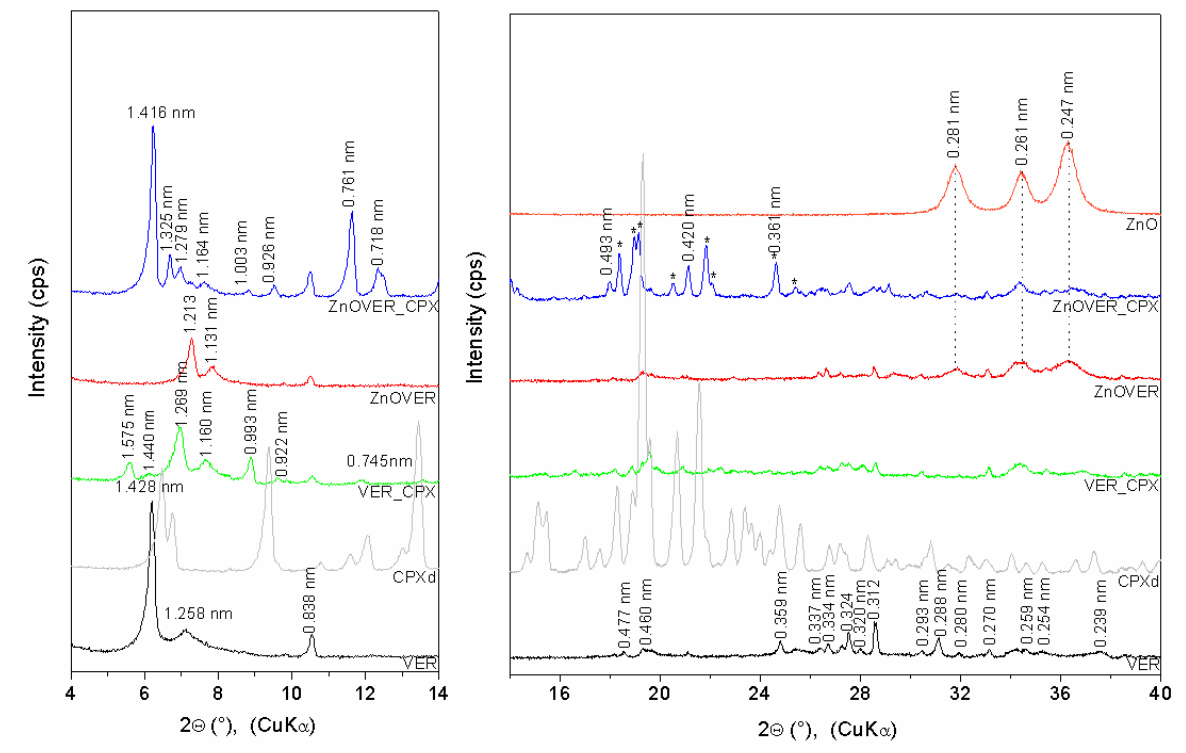
Polymers 2021 , 13 , x FOR PEER REVIEW Figure 1. XRD patterns of initial VER and ZnOVER, VER_CPX, and ZnOVER_CPX nanofillers, and CPXd, ZnO. The XRD pattern (Figure 2) of pure PCL shows characteristic PCL reflections of the orthorhombic crystalline PCL structure at 21.38°, 22.05°, and 23.73° 2 θ ( d -values 0.415 nm, 0.403 nm, and 0.375 nm), and a low, intense, wide reflection at 15.72° 2 θ (0.563 nm) confirmed a semicrystalline PCL structure [44,45]. XRD patterns of nanocomposite samples show other reflections with very low intensities due to the low content of fillers (1wt%). The PCL/VER sample shows reflections belonging to vermiculite at 6.19° (1.427 nm) and tremolite at 10.54° (0.839 nm). The XRD patterns of PCL/ZnOVER and PCL/VER_CPX show only subtle reflections for PCL/ZnOVER at 7.21° (1.224 nm) and PCL/VER_CPX at 6.77° (1.300 nm).